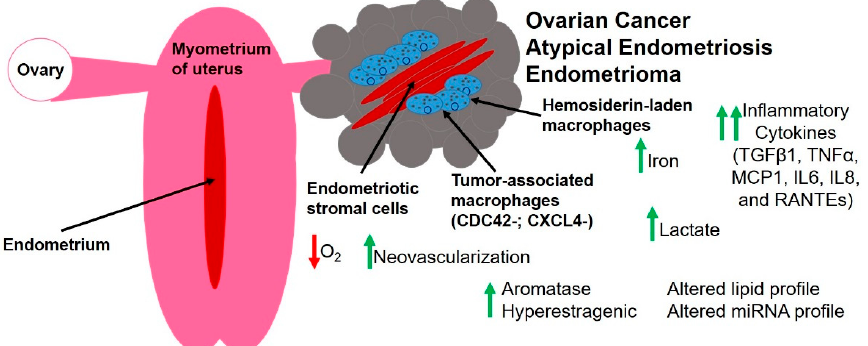
Figure 1. Composition of the endometriotic tumor microenvironment. Endometriosis represents a pathologically benign disease. Endometriosis may be classified into endometriomas, superficial peritoneal disease, or deep infiltrating endometriosis (invasion > 5 mm). Although deep infiltrating endometriosis is invading, typically into the muscularis layer of the bowel, it is clinically not associated with ovarian cancer. Endometriomas are epithelial lined cysts of the ovary, which can be filled with a brown cyst fluid, and thus the name “chocolate cysts.” Endometriomas can be associated with ovarian cancer, with atypical endometriomas having a higher risk of malignant transformation. Atypical endometriomas are characterized by epithelial cells with enlarged hyperchromatic and pleomorphic nuclei, with cellular crowding and high nuclear-to-cytoplasmic ratio. The